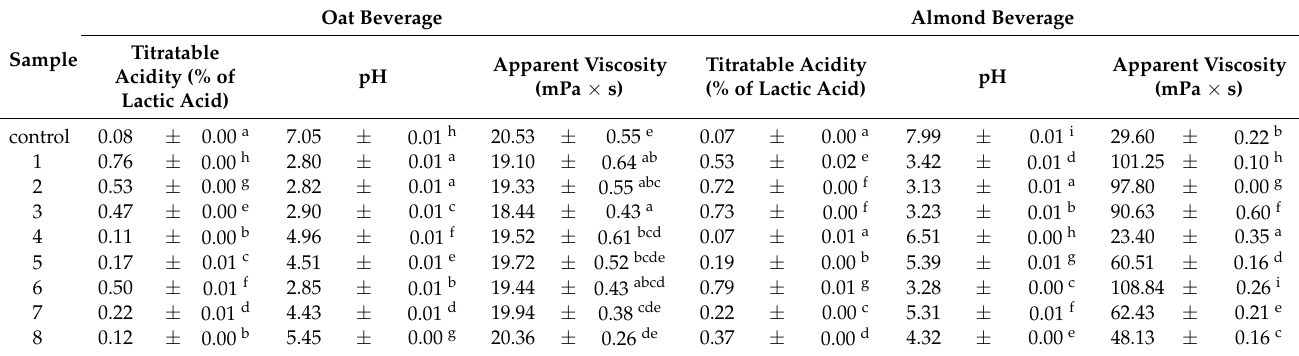
Table 2. Acidity and apparent viscosity of the control and fermented (48 h)